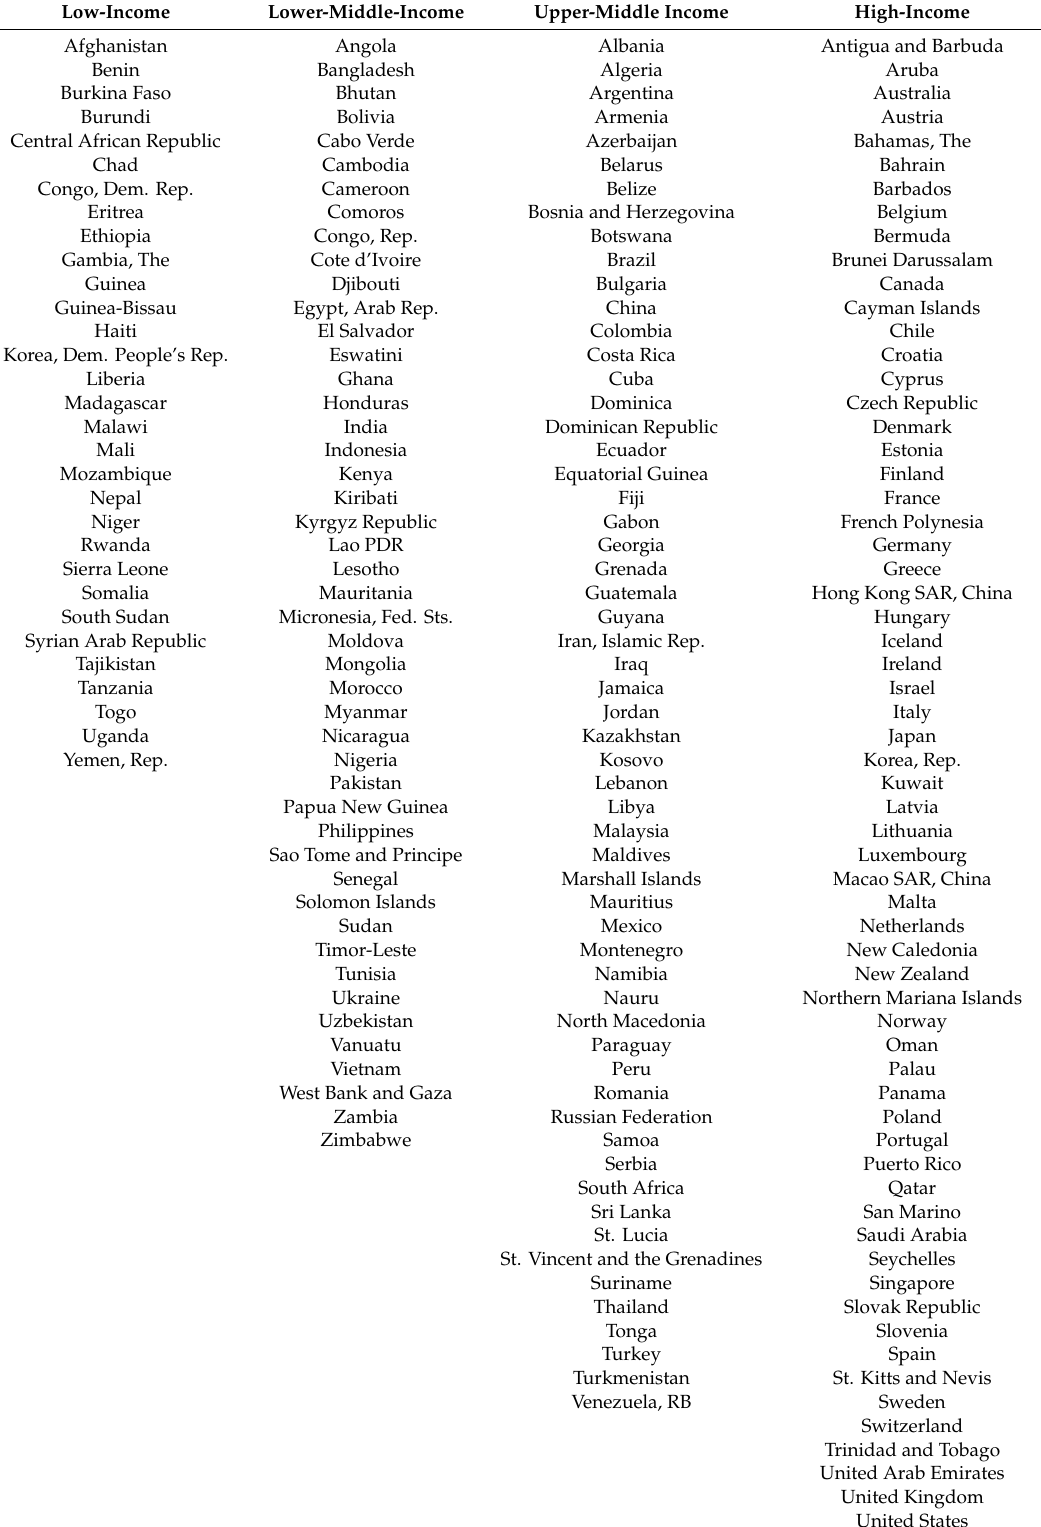
Table A1. List of countries in